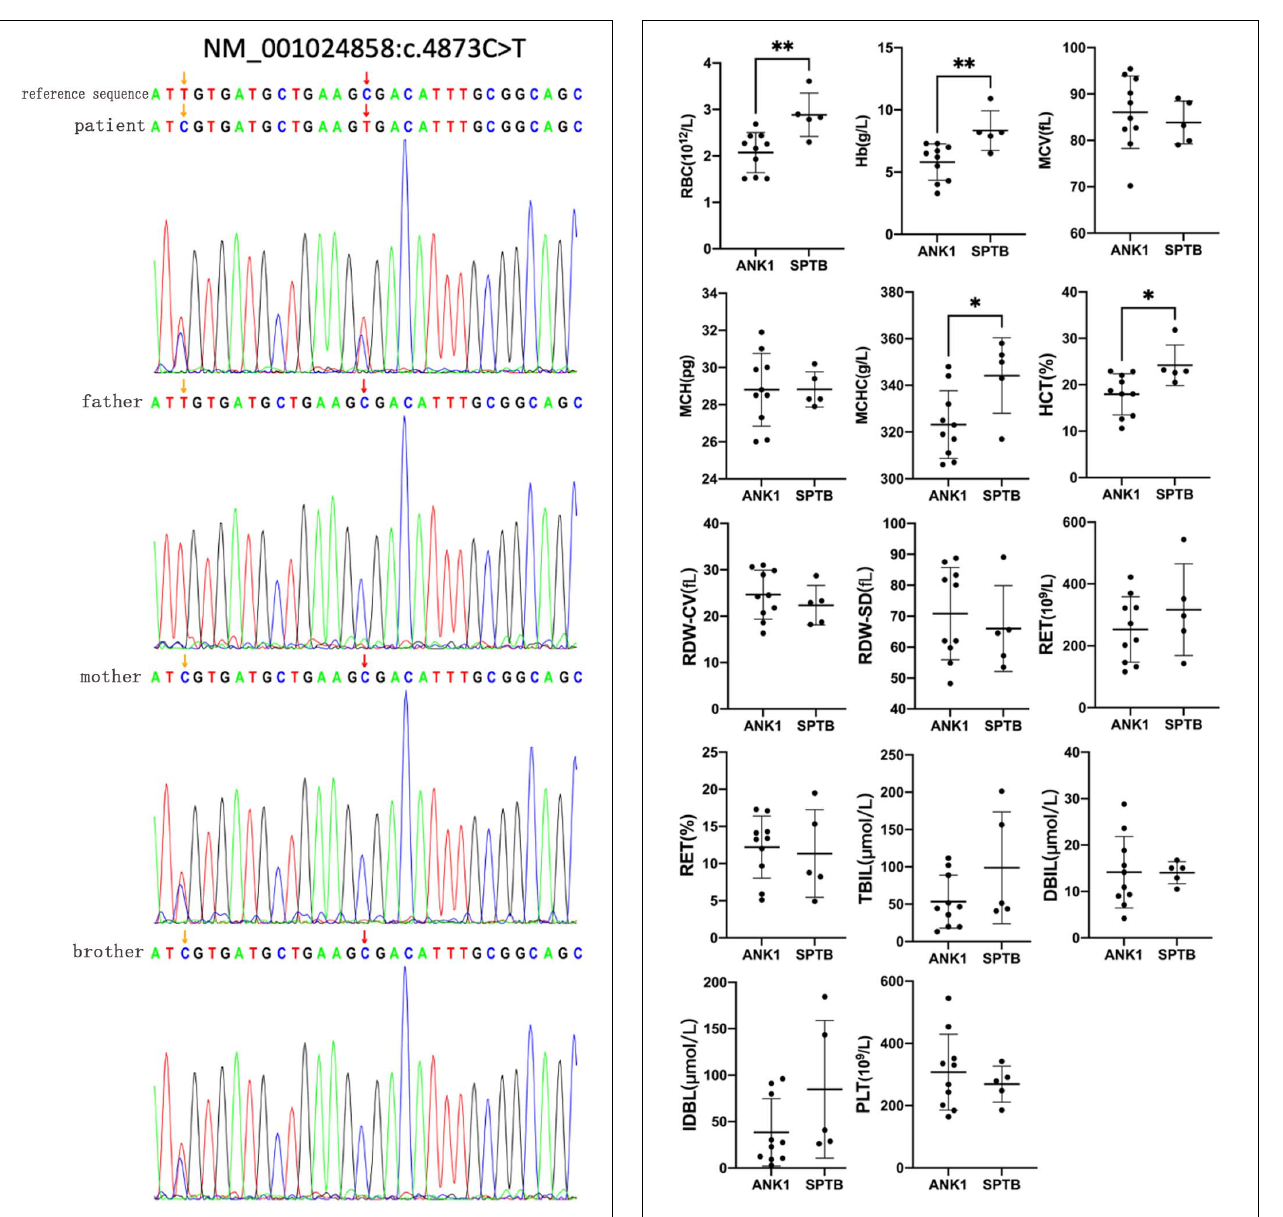
associated with the mildest diseases. At present, Qin et al.